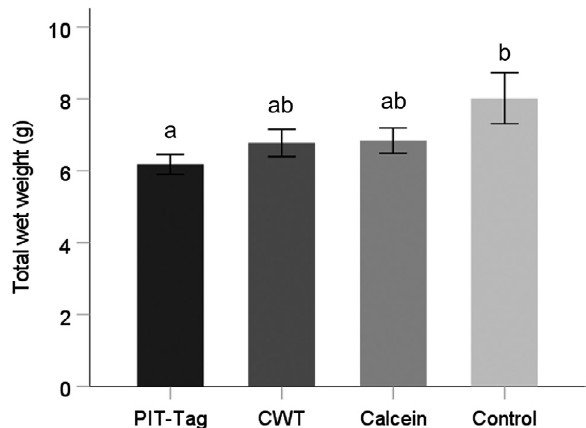
Fig. 1. – Individual total wet weight (mean ± se) of Paracentrotus lividus at the end of a 60-day rearing in the laboratory after tagging with PIT-tags, coded wire tags (CWTs) and calcein, including an untagged control (n=30 individuals per treatment, except the CWT group, n=29). Note: bars sharing the same letter are not significantly different (p>0.05).